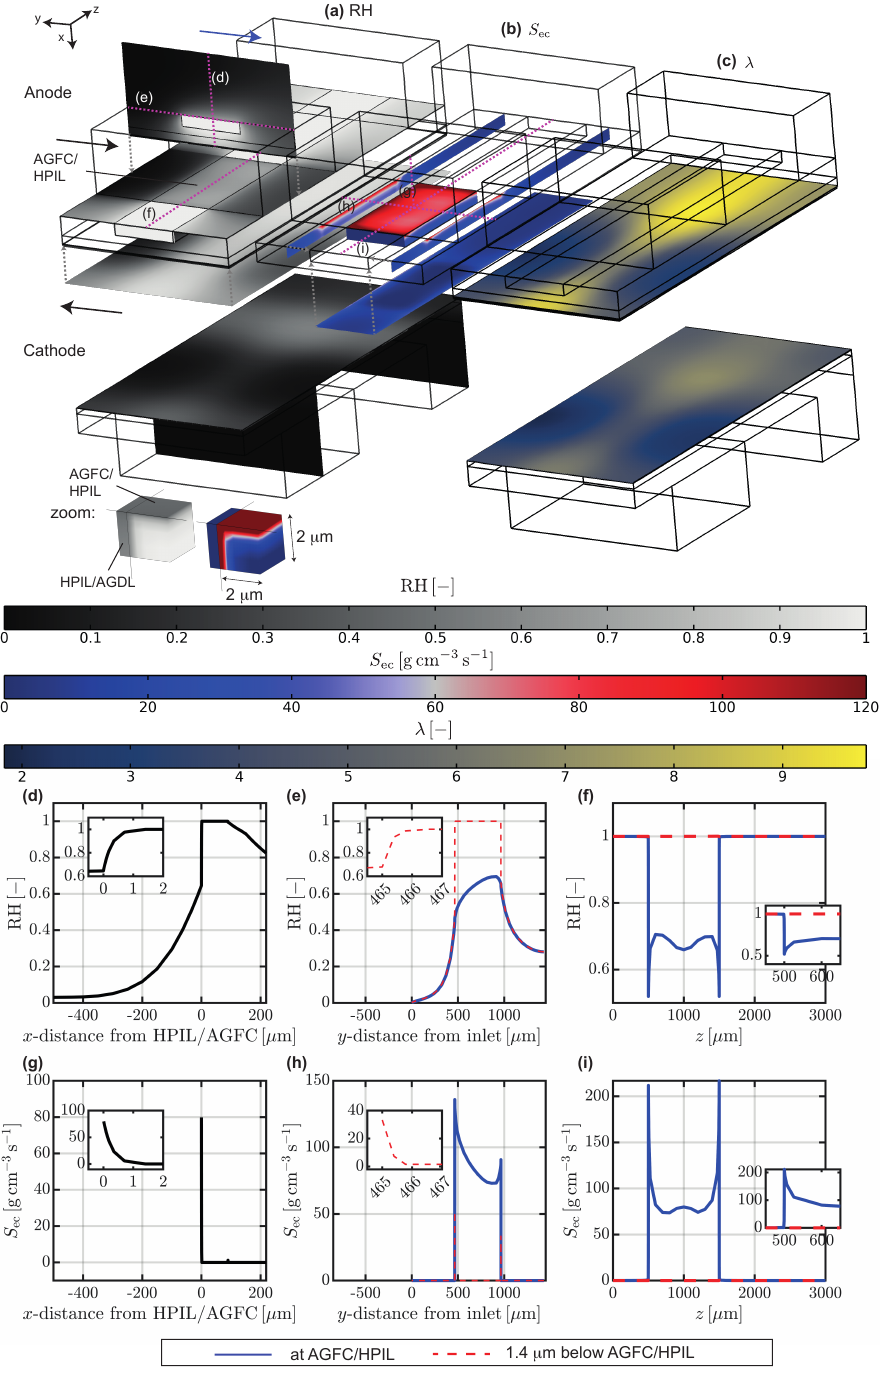
Figure 5. Base case model results: ( a ) relative humidity, ( b ) evaporation source term, and ( c ) dissolved water content. Anode and cathode are separated for visibility. Cubes of 2 µ m length show a zoom of ( a , b ) at the AGFC/HPIL/AGDL triple junction. Profiles of relative humidity ( d – f ) and evaporation source term ( g – i ). Magenta dashed lines in ( a , b ) indicate each profile’s